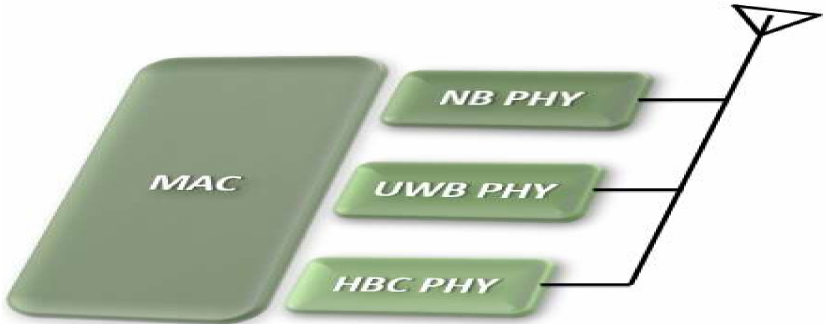
Figure 3. IEEE 802.15.6 Media Access (MAC) and Physical (PHY) layer